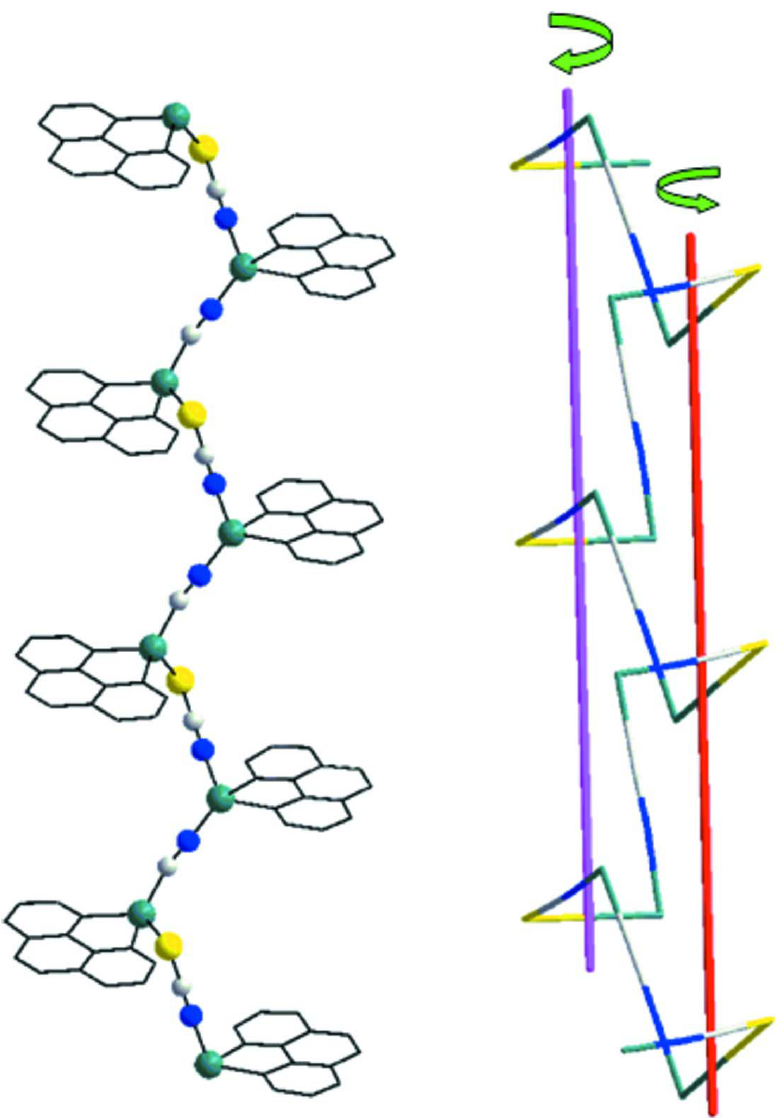
Left: presentation of the location of the copper centres of coordination polymer; Right: View of the meso -helical